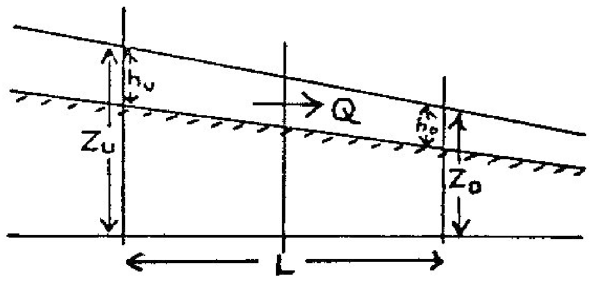
Fig. 4. Demonstration of overland flow across the square grid boundary; source: DHI (2007).